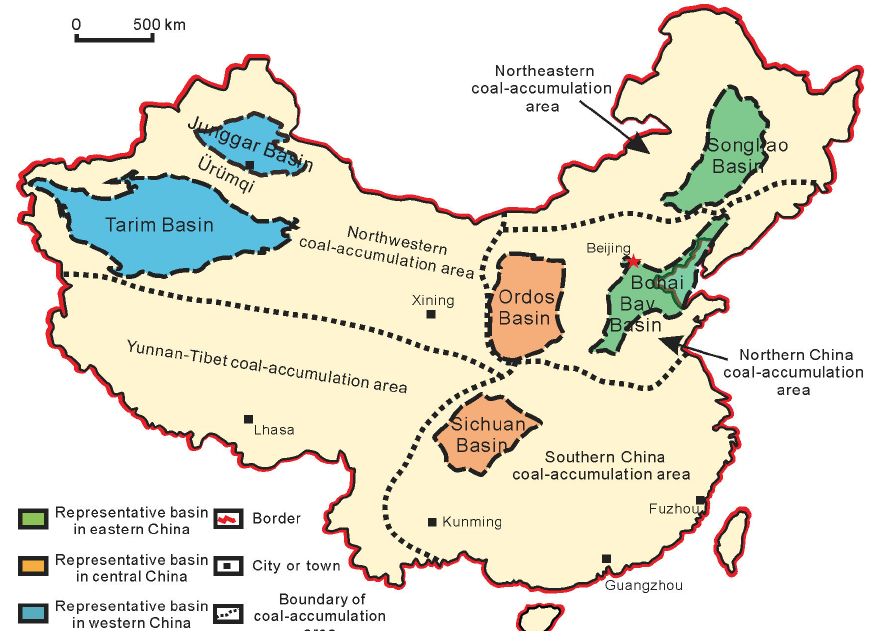
Figure 1. Location of the six representative petroliferous basins and five coal-accumulation areas in China. The studied petroliferous basins, plotted on the China mainland, are pigmented with different colors according to their locations in China. The five coal-accumulation areas, bounded by large geological structural belts, are mapped according to Zhu